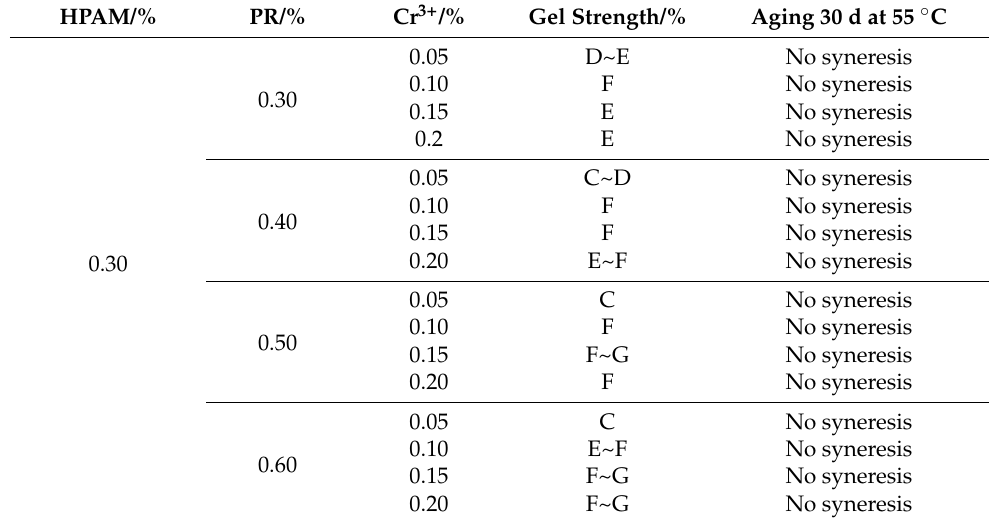
Gel strength and long-term thermal stability of the gel system prepared via 0.30% HPAM + PR and Cr 3+ cross-linker.